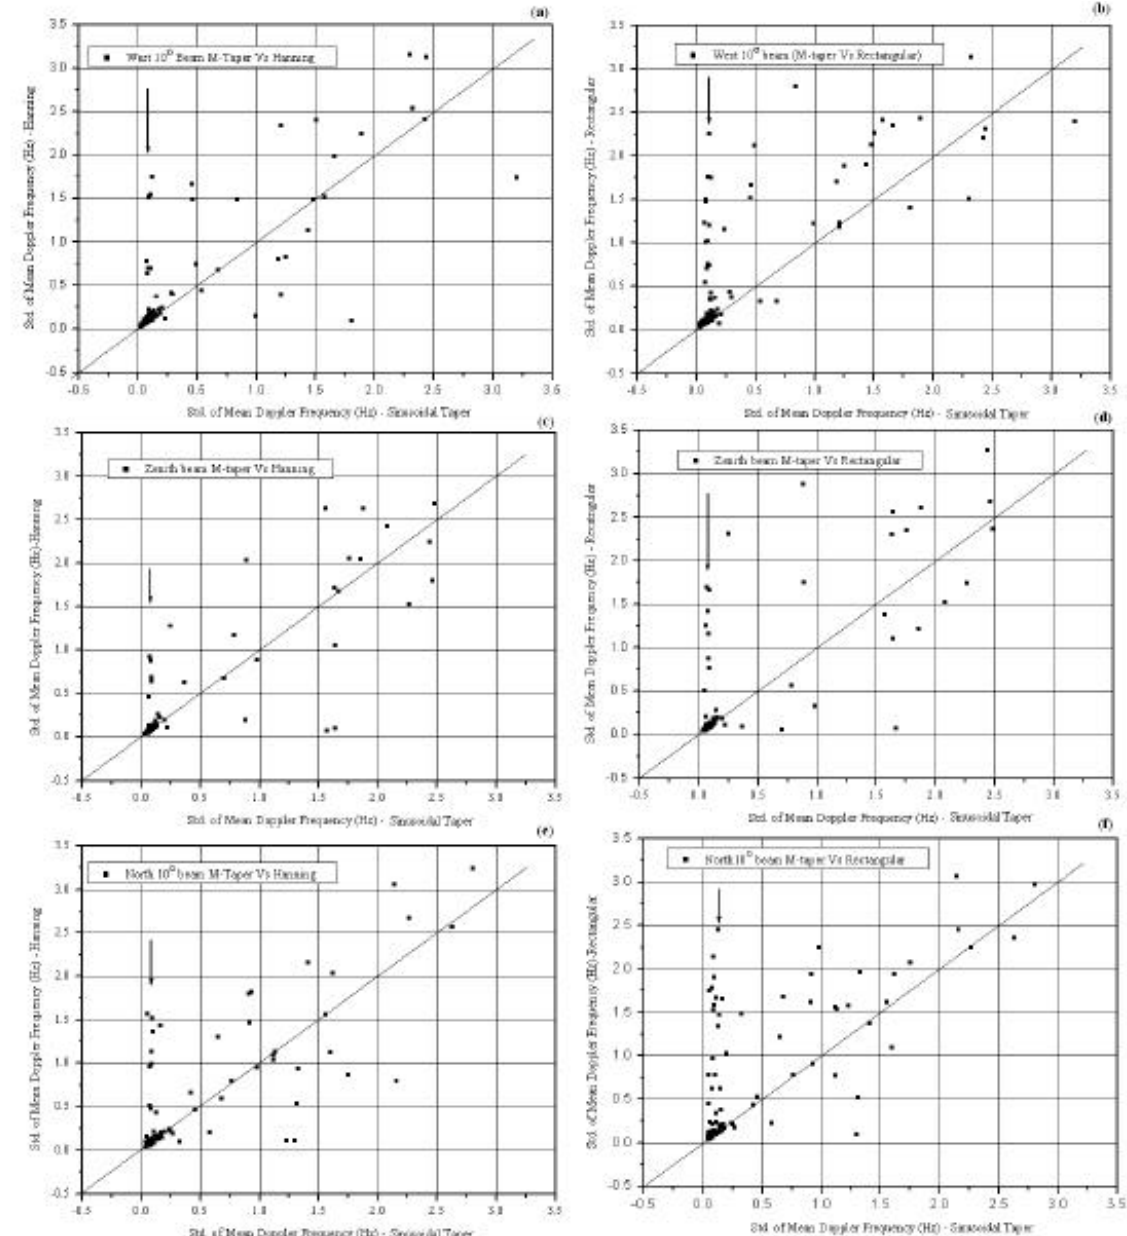
Fig. 3. Comparison of the standard deviation of the mean Doppler frequency for sinusoidal taper vs. Hanning taper, and sinusoidal taper vs. rectangular taper, (a) and (b) for west 10 ◦ beam, (c) and (d) for zenith beam, (e) and (f) for north beam, respectively, observed on 10 May